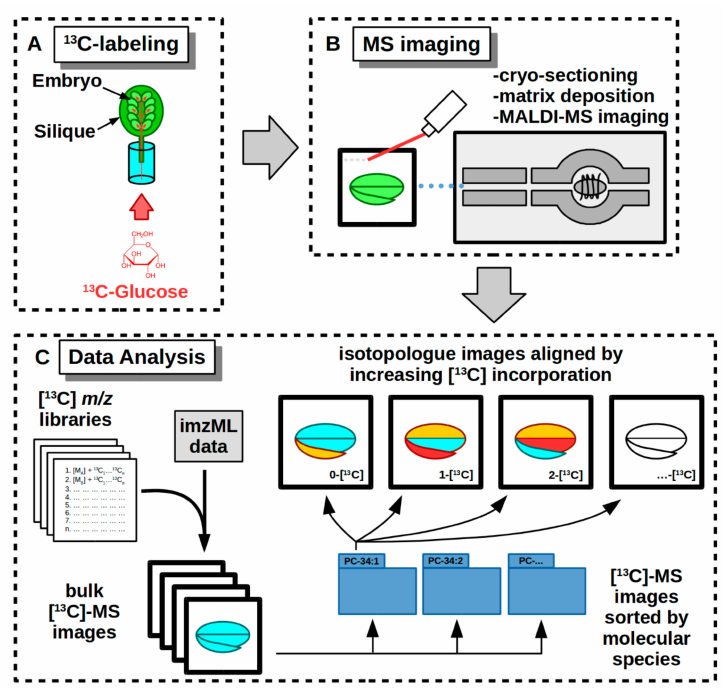
Figure 2. Workflow of a 13 C-MSI experiment on developing embryos from Camelina and pennycress siliques. ( A ) Cut siliques are fed with media containing [U- 13 C]-glucose which is then metabolized and incorporated into the endogenous metabolites. ( B ) 13 C-labeled seeds are dissected from siliques and prepared for MS imaging. ( C ) Raw data from MS imaging is converted to imzML format and is searched for images using [ 13 C] m/z libraries. Isotopologue images are collected in bulk, sorted by molecular species, and then aligned by increasing 13 C incorporation to show distribution of isotopically labeled molecular